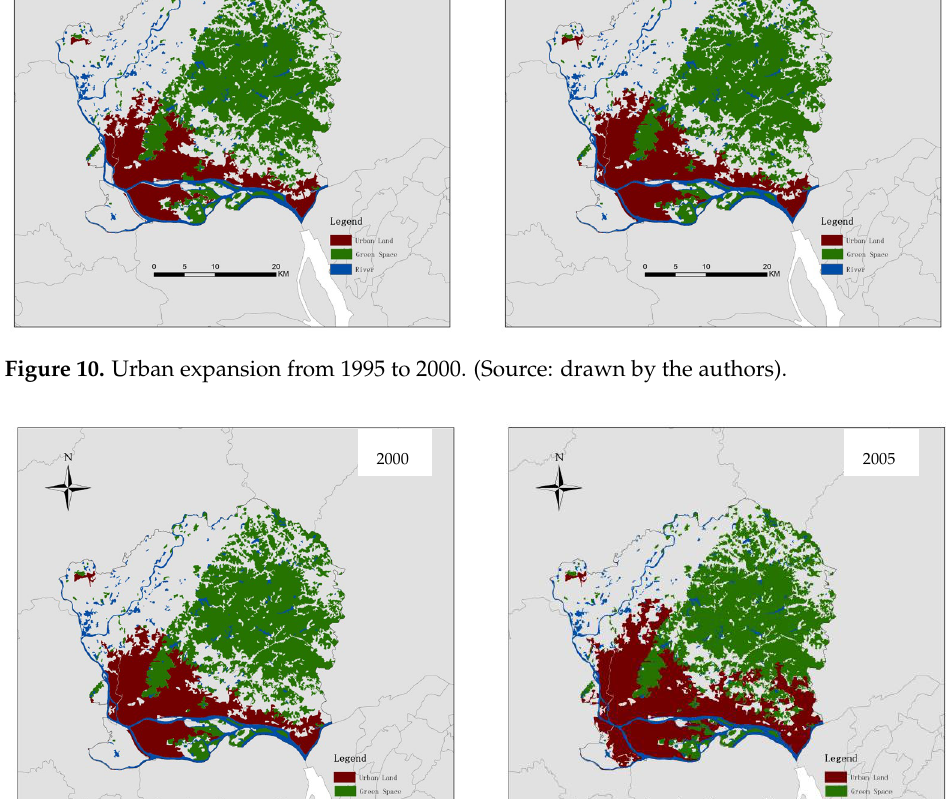
Figure 11. Urban expansion from 2000 to 2005. (Source: drawn by the authors).